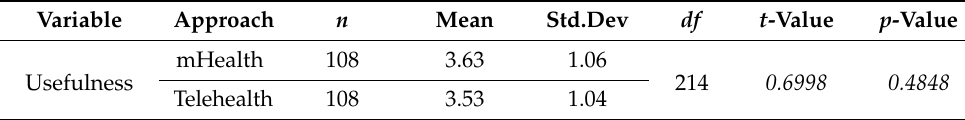
214 0.6998 0.4848